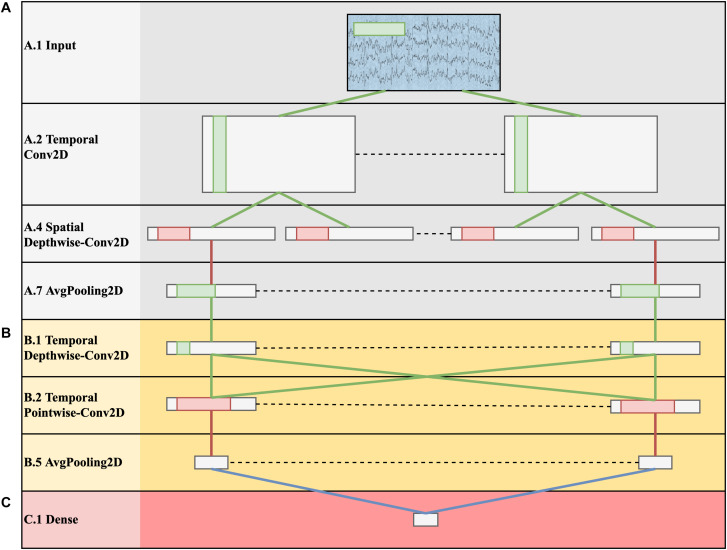
Architecture schematization of the winning solution ID-1 based on EEGNet. The represented shapes correspond to the output of each layer. Green lines represent convolutional connections, red lines pooling connections, and blue lines dense connections. The CNN is composed by a temporal and spatial feature extractor (A), a summary feature extractor (B) and a classification module (C).